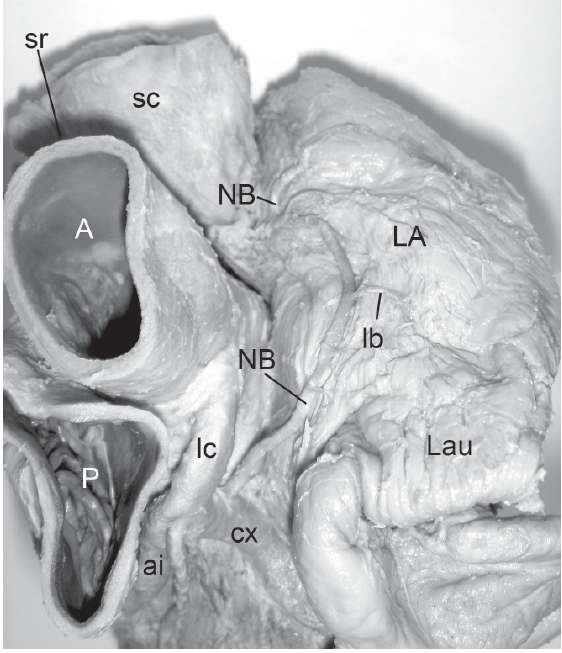
Figure 3 - The sinuatrial nodal branch (NB) is type L1